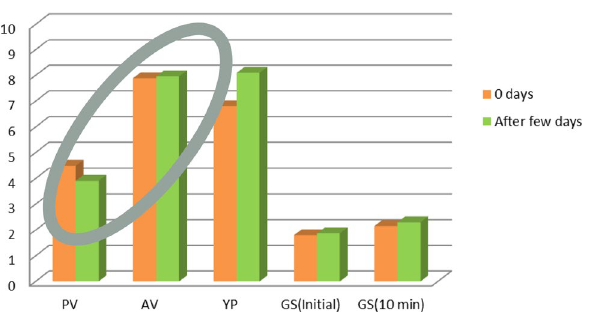
Fig. 28 Rheological properties of non-optimized vs optimized PHPA–bentonite mud